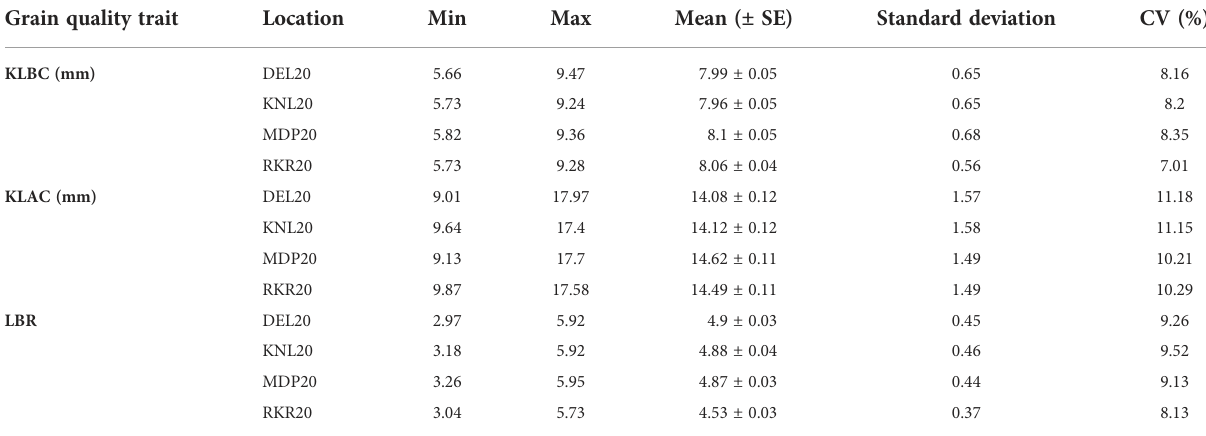
TABLE 2 Summary statistics of three, grain quality traits recorded on 172 breeding lines evaluated across four environments. Grain quality trait Location Min Max Mean (± SE) Standard deviation CV (%)